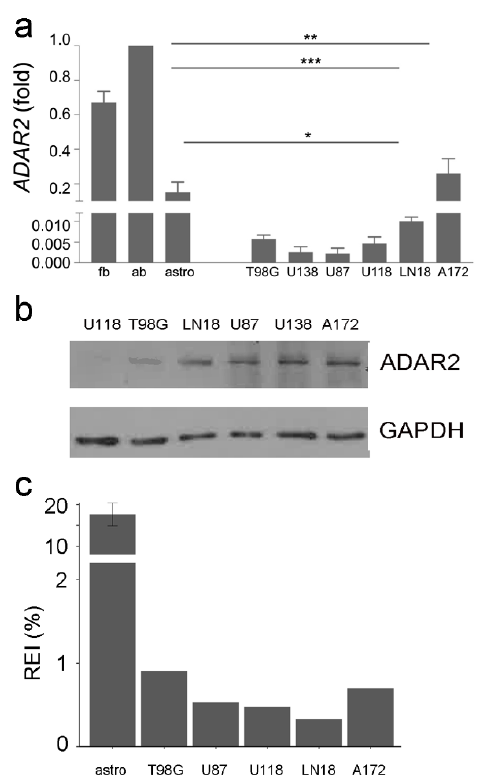
Figure 2. ADAR2 expression level and activity across GBM cell lines. ( a ) ADAR2 expression (qRT- PCR) in normal brain (fetal and adult), astrocytes, and glioblastoma cell lines (T98G, U138-MG, U87-MG, U118-MG, LN-18, and A172). Ct values were normalized to GAPDH mRNA levels. Mean ± standard deviation ( n = 3), values are representative as means ± SD, * p ≤ 0.05; ** p ≤ 0.01; *** p ≤ 0.001. Of note, ADAR2 activity is more robust in the whole brain (either adult or fetal) because of neuronal cells, where ADAR2 is highly active. ( b ) Western blotting analysis showing the ADAR2 level in glioblastoma cell lines. No control was added as the ADAR2 level was too high. ( c ) The recoding editing index (REI) in normal astrocytes (×10), T98-G, U87-MG, U118-MG, LN-18, and A172 glioblastoma cells lines is shown. REI values were calculated as the weighted average of editing levels over all known recording sites from the highly accurate list.